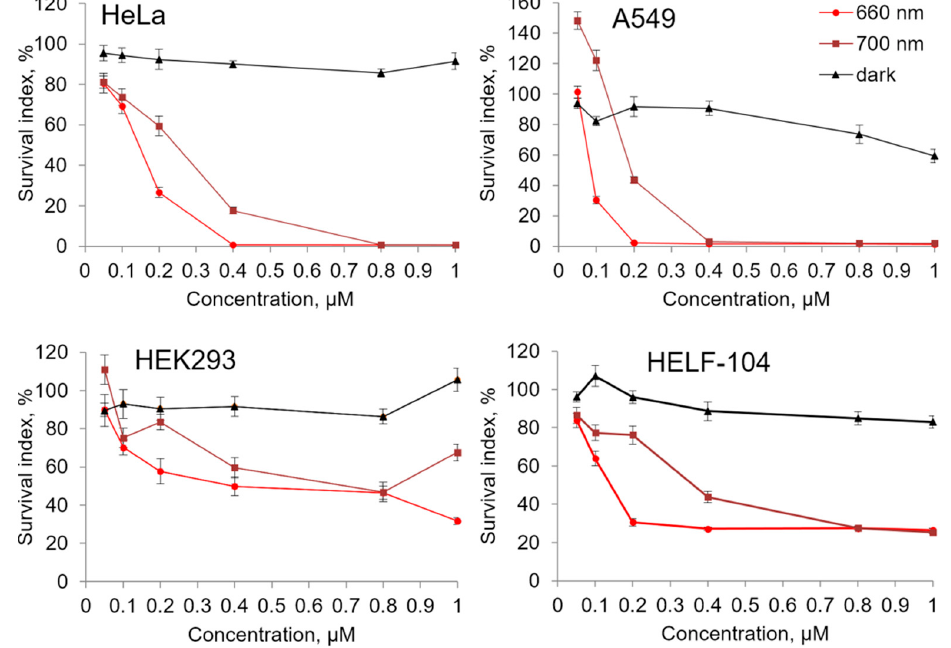
Figure 3. Photoinduced cytotoxic activity of Compound 21 against four cell lines (HeLa, A549, HEK293, and HELF-104). After 2 h of preincubation, the tested compound was photoactivated by 20 min exposure to 660 or 700 nm light followed by incubation in the dark for 70 h.